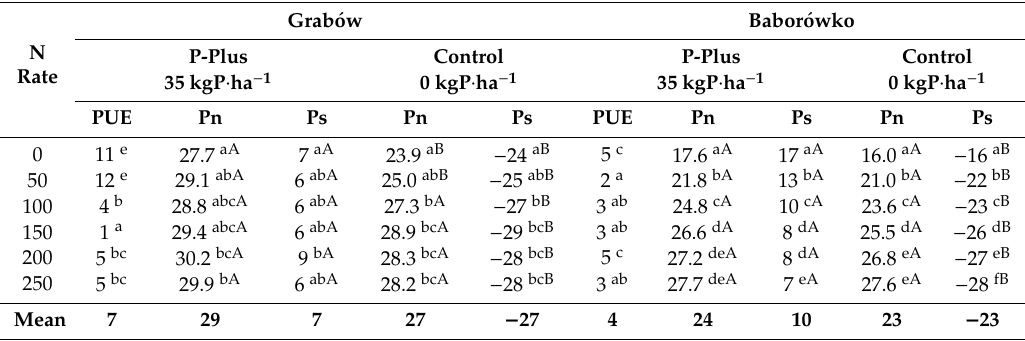
Table 3. P use indices for maize; N fertilizer rate; P fertilizer rate; Pn (uptake) and Ps (surplus) (kg · ha − 1 ); PUE